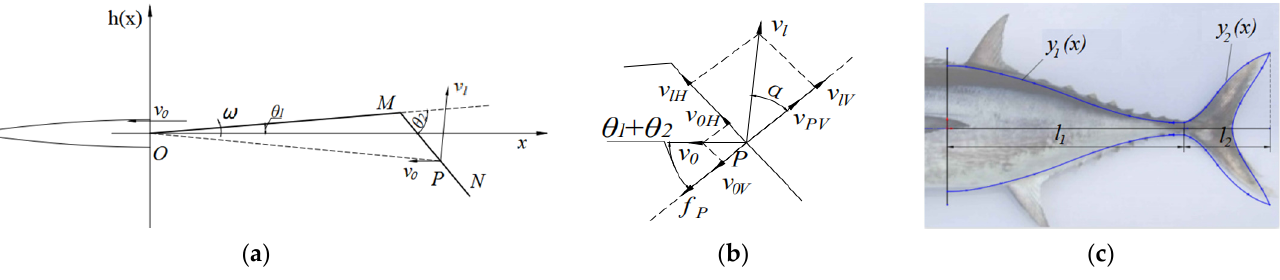
Figure 1. Modeling of fishtail of two-joint connecting rod structure. ( a ) Schematic diagram of two-joint connecting rod structure. ( b ) Forces on a random point on the caudal fin. ( c ) Fitting the profile curve of the fish according to the actual shape of the tuna.